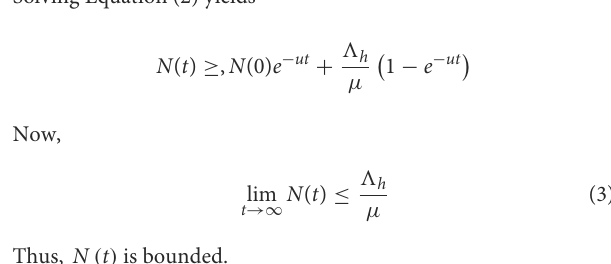
TABLE 1 Description and values of parameters for model (Equation